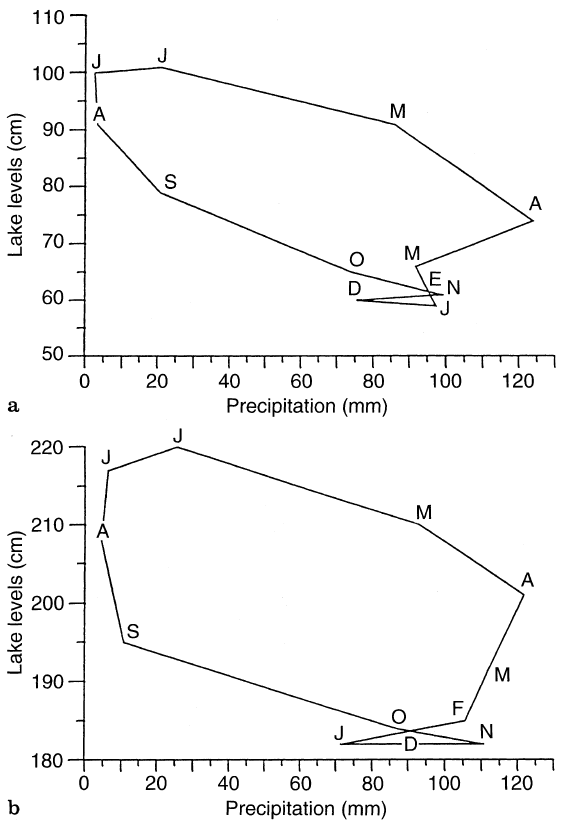
Fig. 7a, b. Lake level-Tatvan precipitation polygon a 1944–1968 period, b 1969–1994